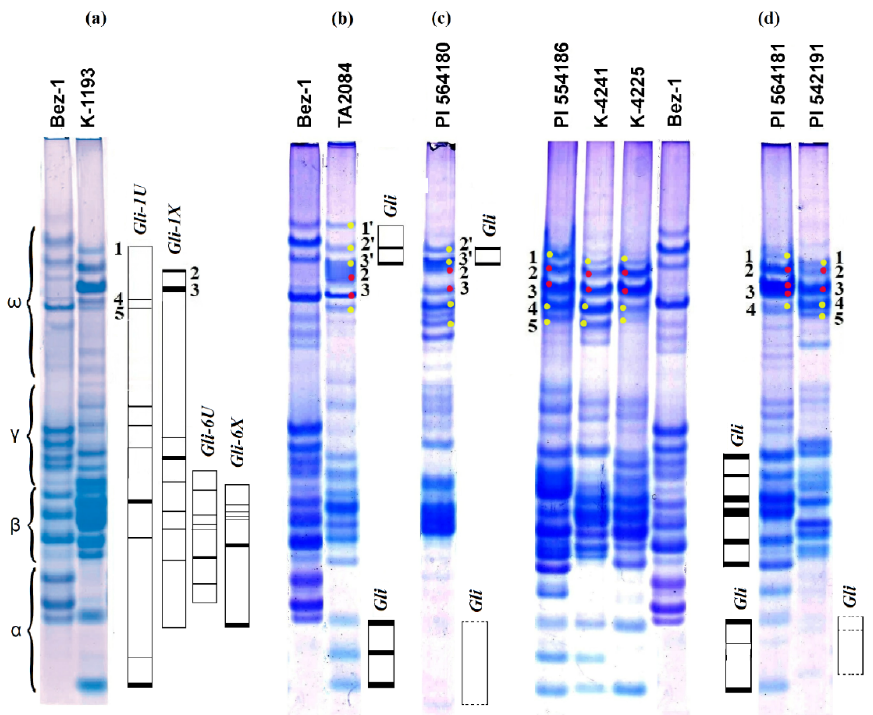
Figure 9. Ae. columnaris with the most distinct gliadin spectra : ( a ) gliadin spectrum of a model Ae. columnaris accession K − 1193 in comparison with etalon spectrum of wheat cultivar Bezostaya − 1 (Bez − 1). Blocks of linked electrophoretic gliadin components controlled by a single locus of the particular Ae. columnaris chromosome [27] are shown schematically at the right side of the electrophoretic spectrum; ( b ) EP spectrum of the accession TA2084 in comparison with wheat cultivar Bezostaya − 1; ( c ) EP spectrum of PI 564180; ( d ) EP spectra of Ae. columnaris accessions illustrating protein components presumably encoded by the X c (red dots) and U c (yellow dots) chromosomes. The unique components, which were not found in any other Ae. columnaris accessions, are shown schematically (parts ( b – d )).